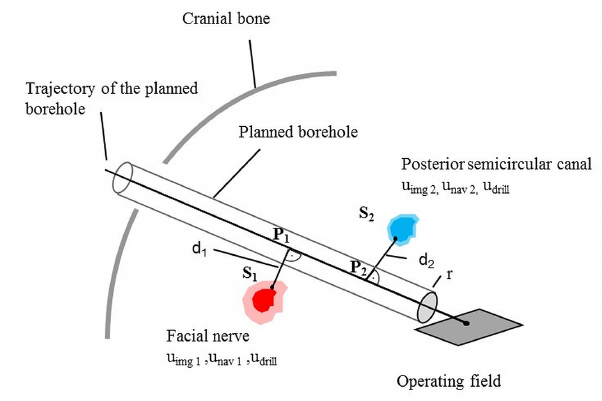
Figure 6. Schematic representation of the critical distances d 1 and d 2